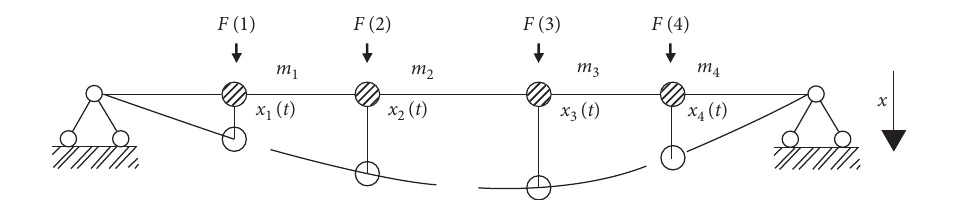
Figure 4: The equivalent multidegree of freedom bearing system.